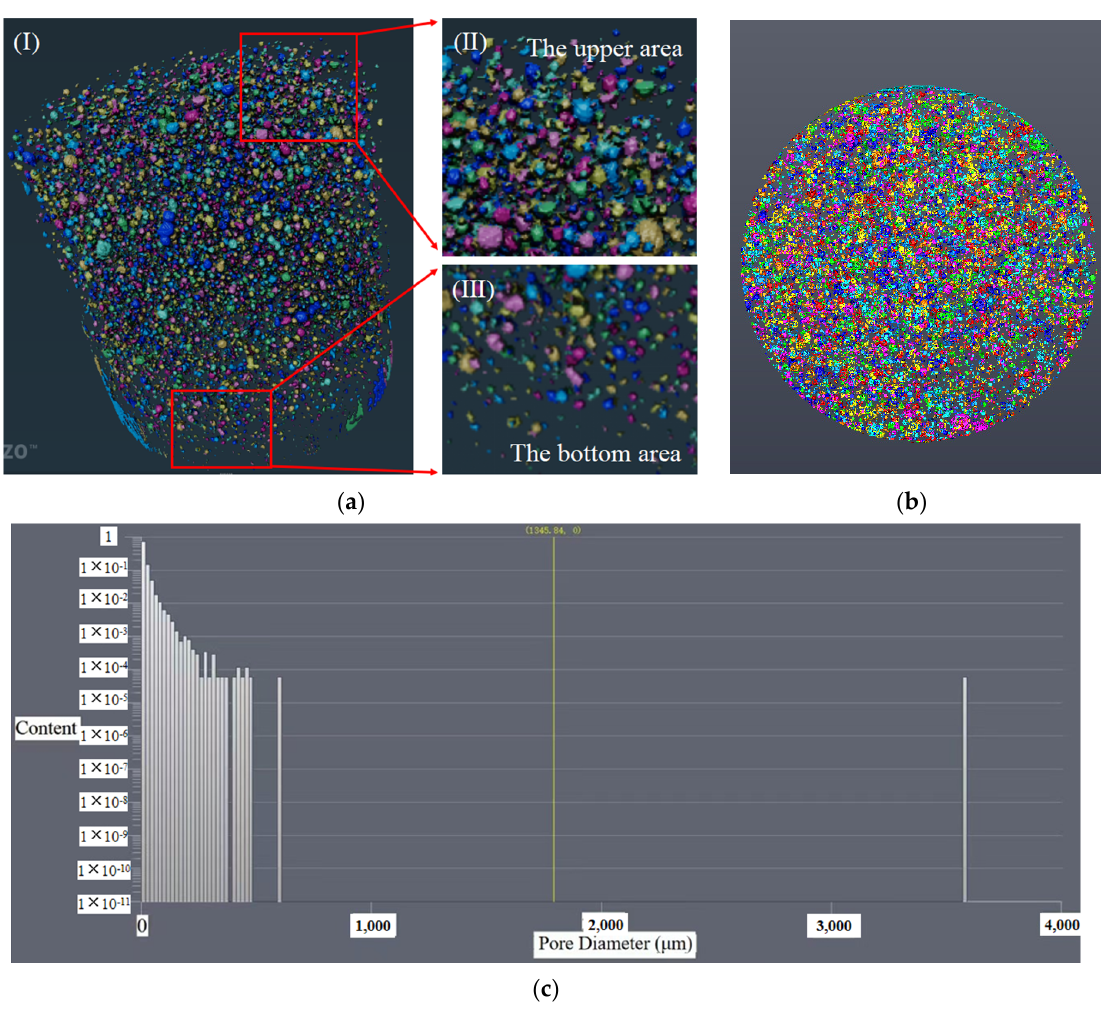
Figure 12. Reconstructed pore structure model of SSUHPC (above 200 μ m): ( a ) Analysis of pore structure characteristics. The І was the whole structure, Ⅱ was the upper area and Ⅲ was the bottom area; ( b ) Top view of pore structure; ( c ) Pore size distribution of SSUHPC.